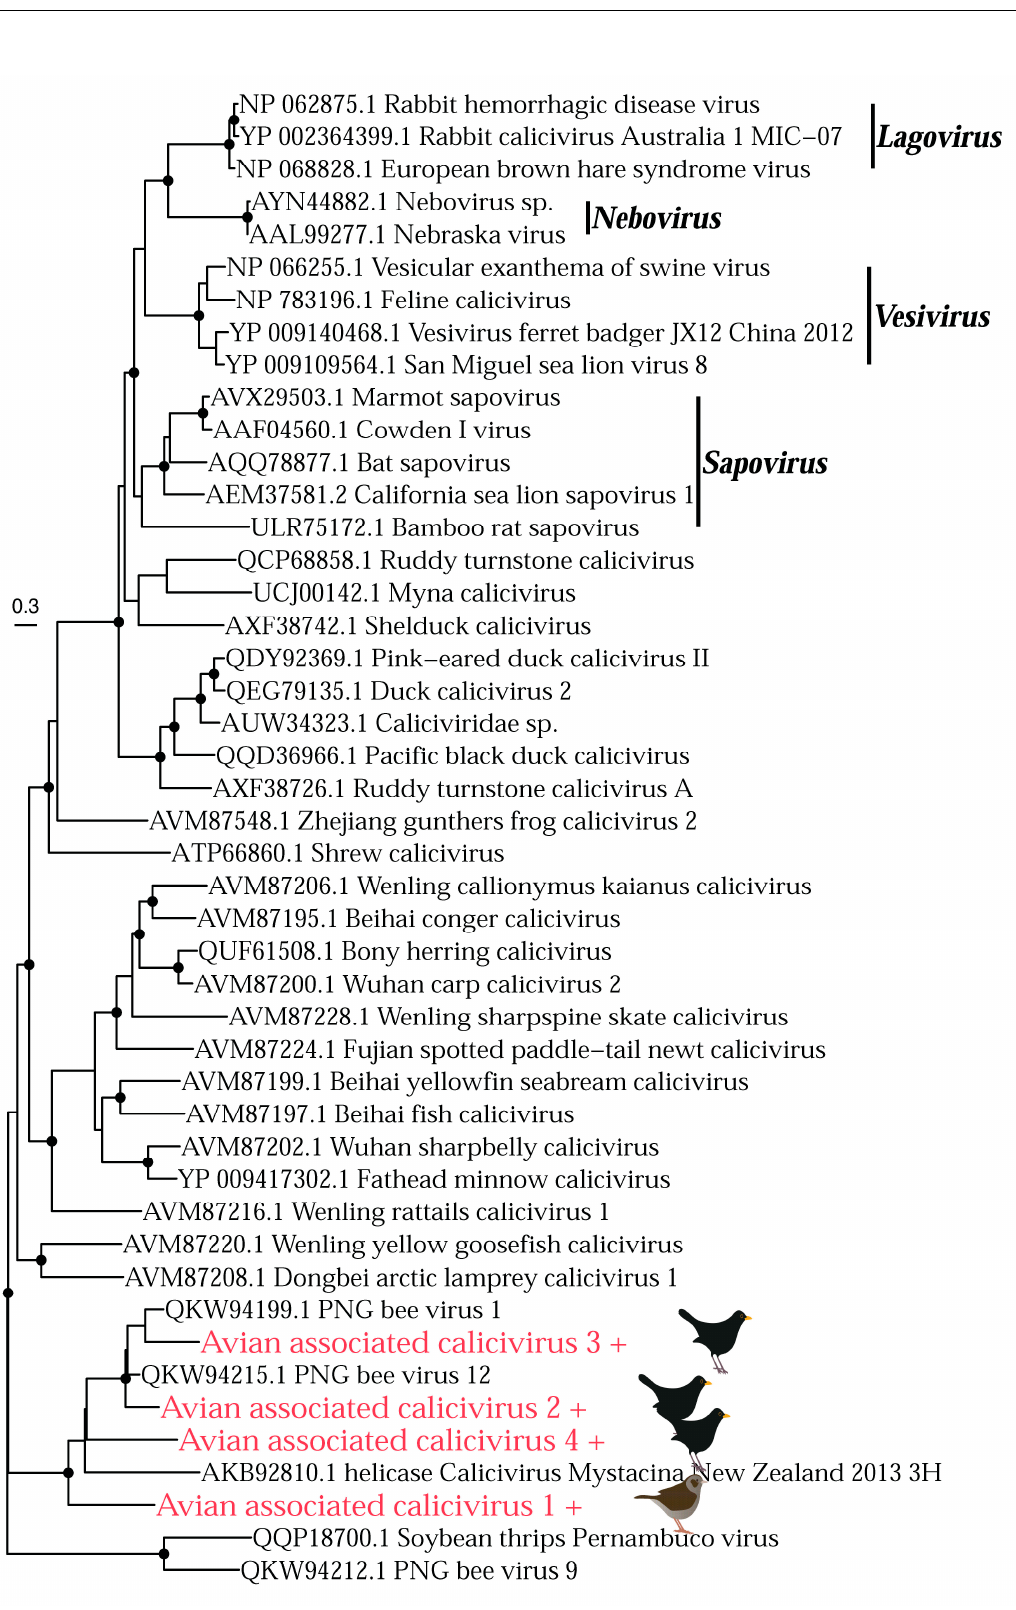
Figure 8. Phylogeny of the Caliciviridae based on the non-structural polyprotein (alignment length of 1087 amino acids). Key genera are shown in black with a black bar; all viruses below bamboo rat sapovirus on the phylogeny have not currently been classified into a genus by ICTV. Colours and symbols as shown in Figure